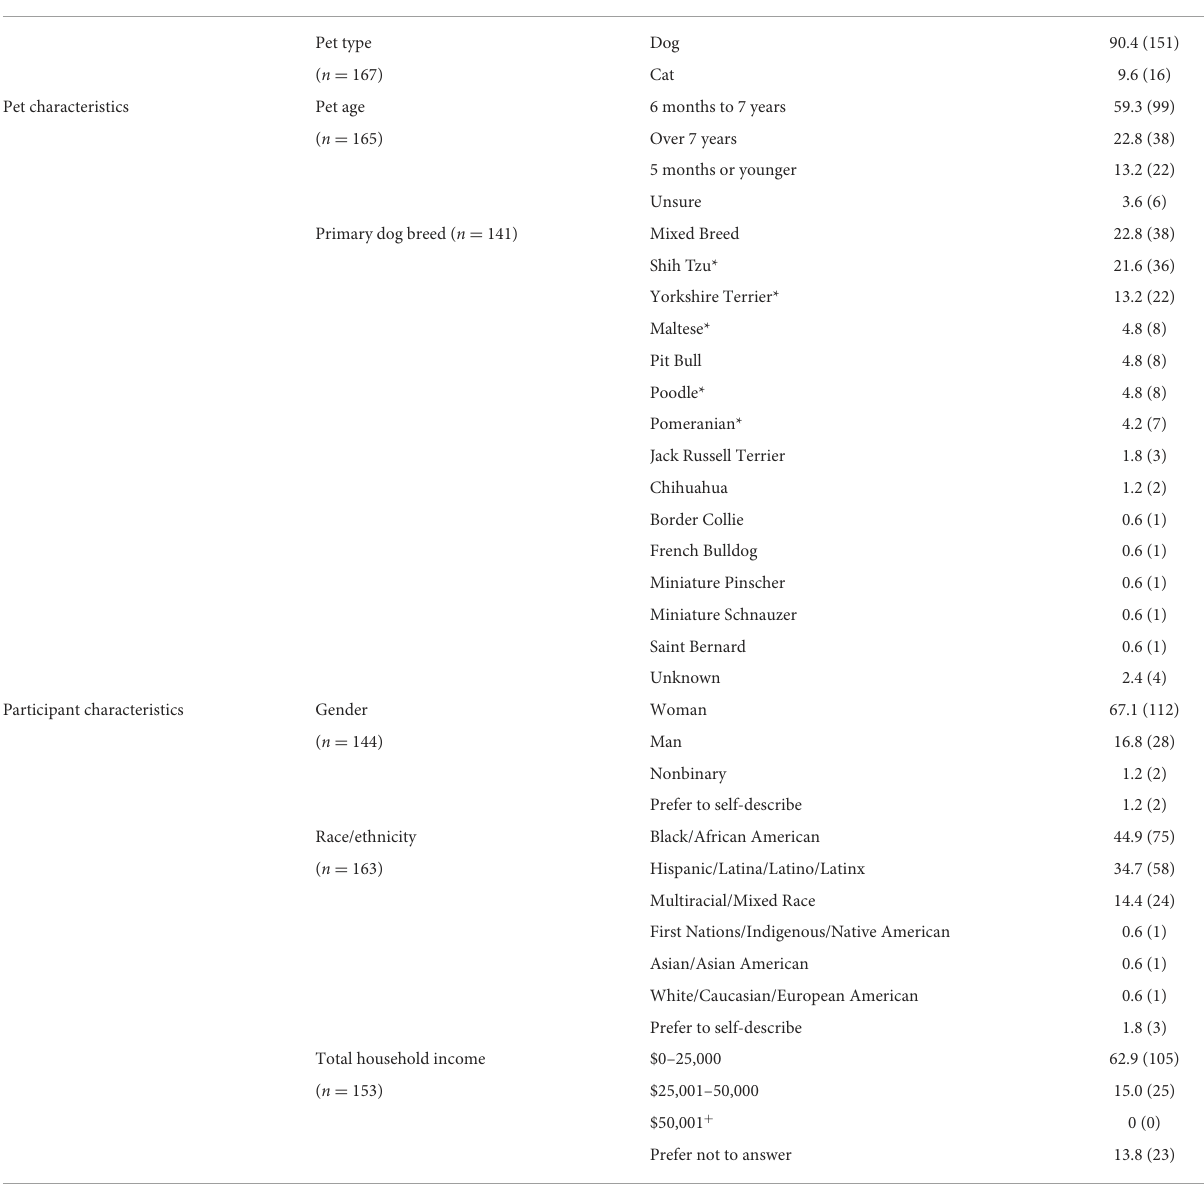
TABLE 1 Demographic characteristics reported by pet